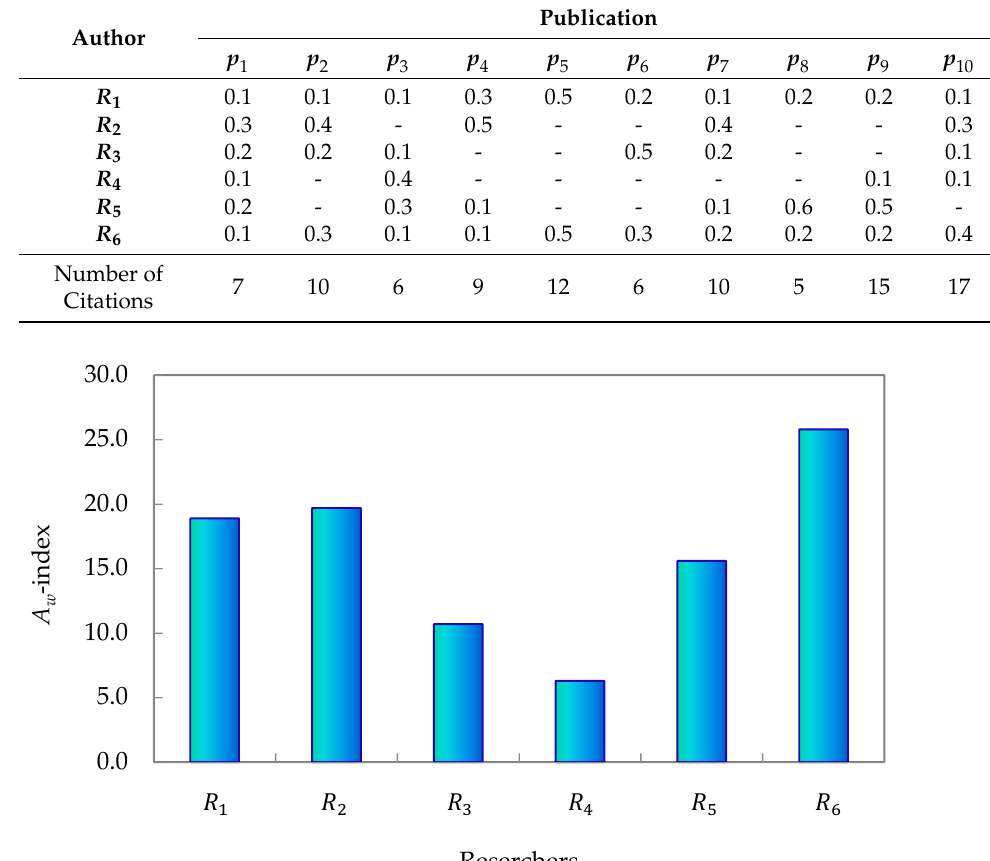
Table 2. Weightage factors of the researchers and number of citations for publications p 1 to p 10 .